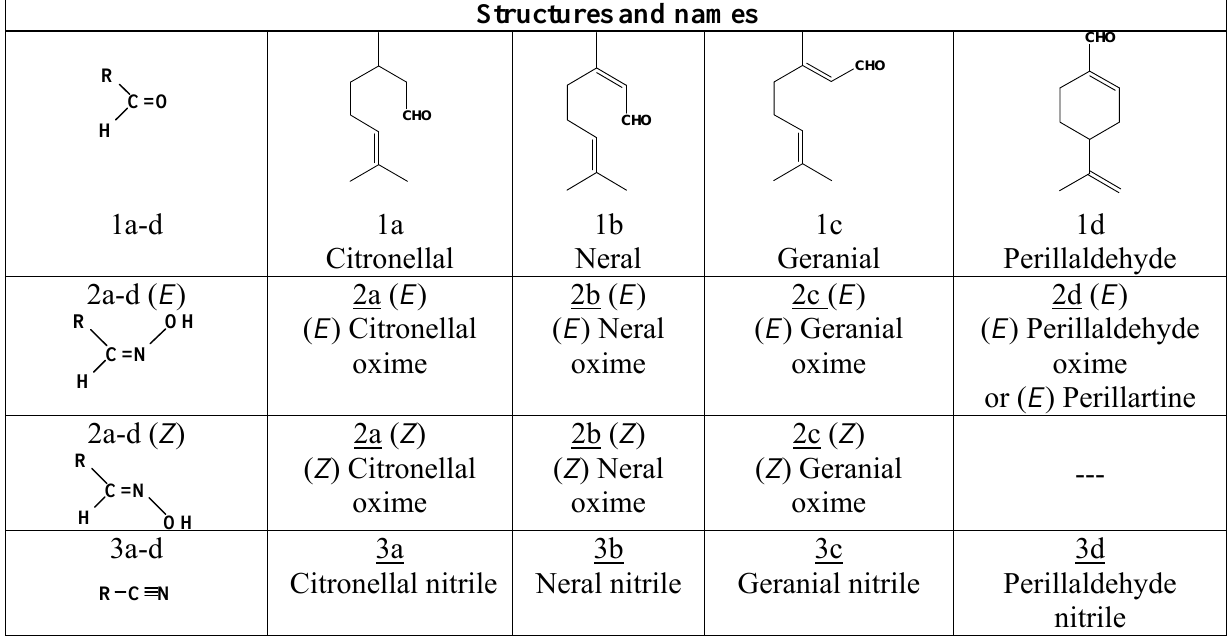
Table 1. Structures of various aldehydes studied and names of oxime and nitrile homologues. Structures and